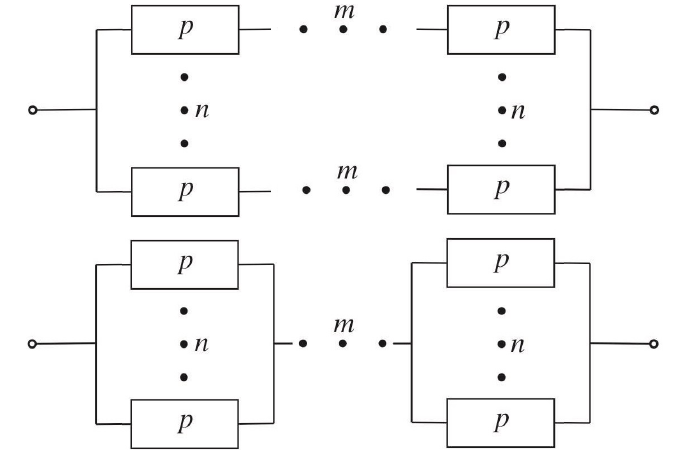
Figure 1. n -multiple block redundancy ( top ), split redundancy ( bottom ) of a chain of length m . Reliability of the network obtained in this way is H n ( m ) = 1 − ( 1 − p m ) n . In the second method, each element of the original chain is n -multiple reserved separately (see Figure 1). Reliability of the newly formed network H n ( m ) = ( 1 − q n ) m , q = 1 − p